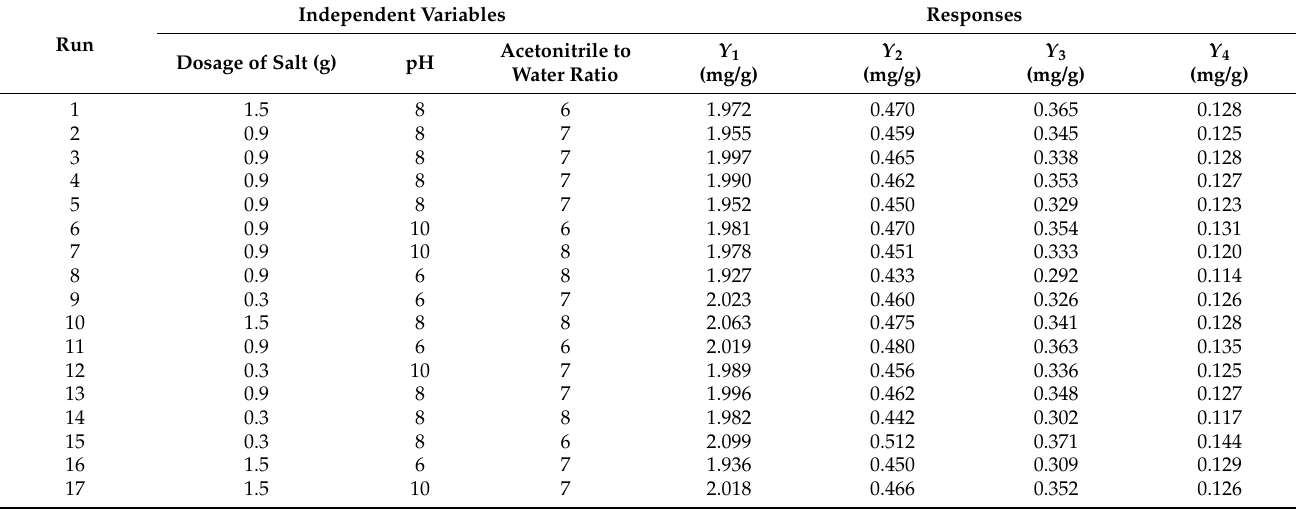
Table 4. Experimental design applied to extraction and responses of 4 ent-abietane diterpenoids in Box-Behnken design